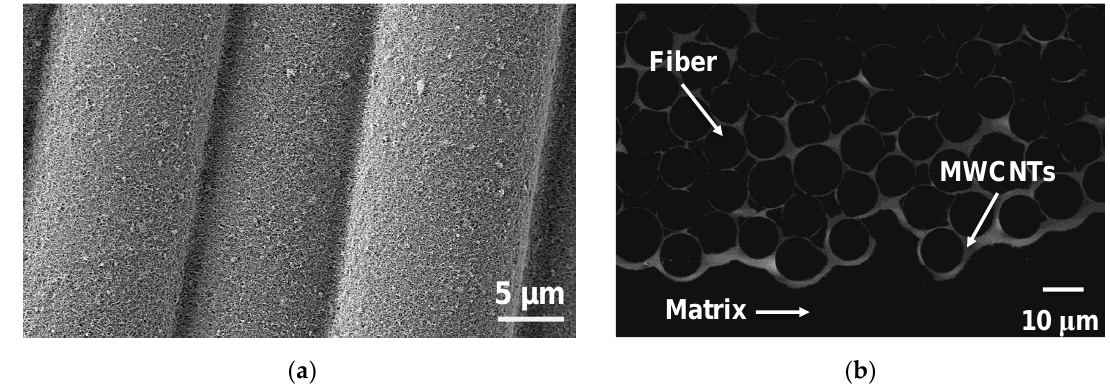
Figure 1. ( a ) SEM micrograph of PEI-MWCNTs deposited onto glass fibers and ( b ) SGIM micrograph of the composite cross-section showing the MWCNT coating (bright) penetrating the fiber bundle.